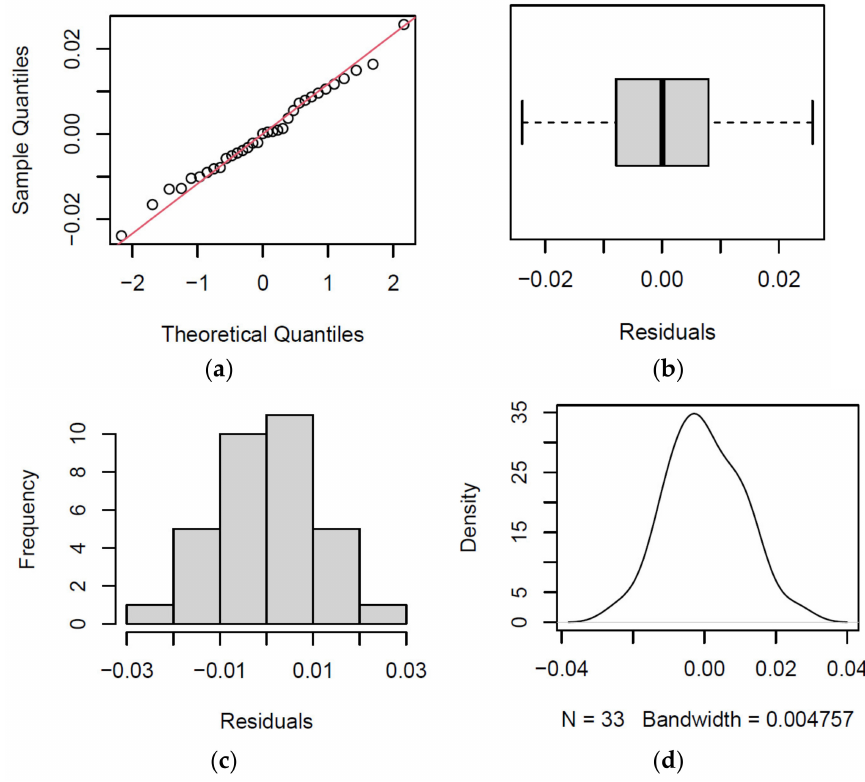
Figure 14. Residue analysis: ( a ) Normal Q–Q Plot; ( b ) Box Plot; ( c ) Histogram; ( d )